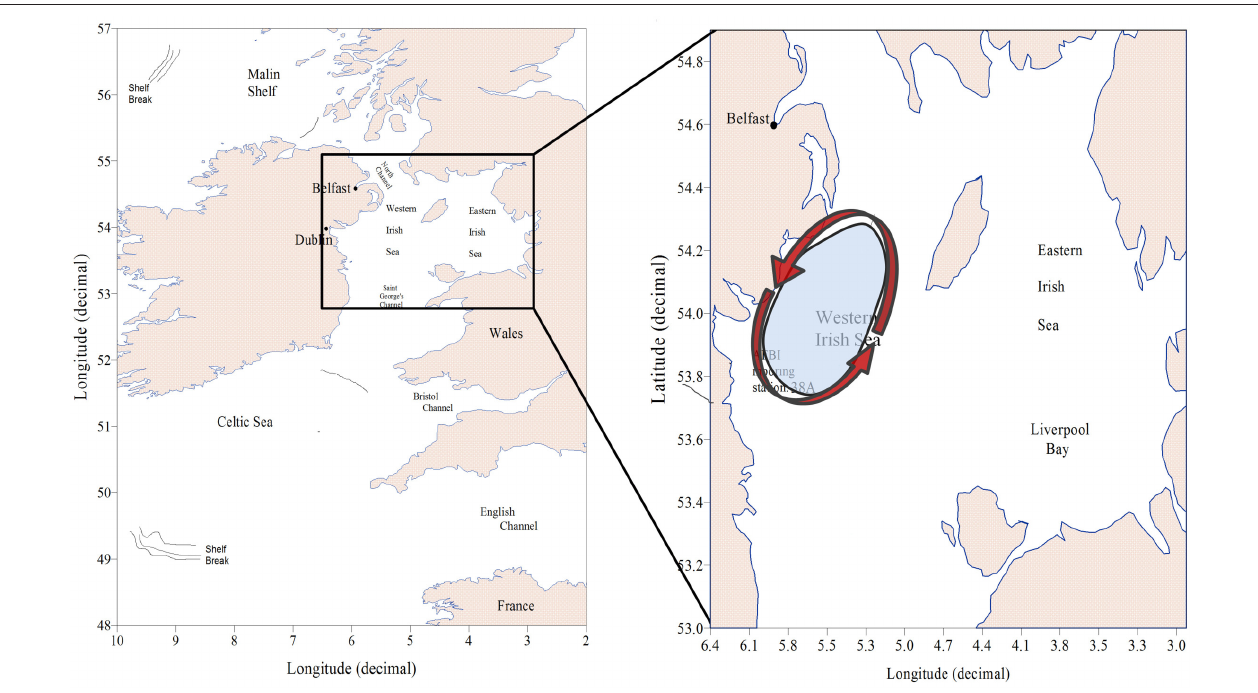
FIGURE 2 | Map of the case study showing the location of the Western Irish Sea, the AFBI mooring station 38A and a cartoon (Hill et al., 2008) illustrating the seasonal cyclic gyre that establishes during spring over the Western Irish Sea (WIS).